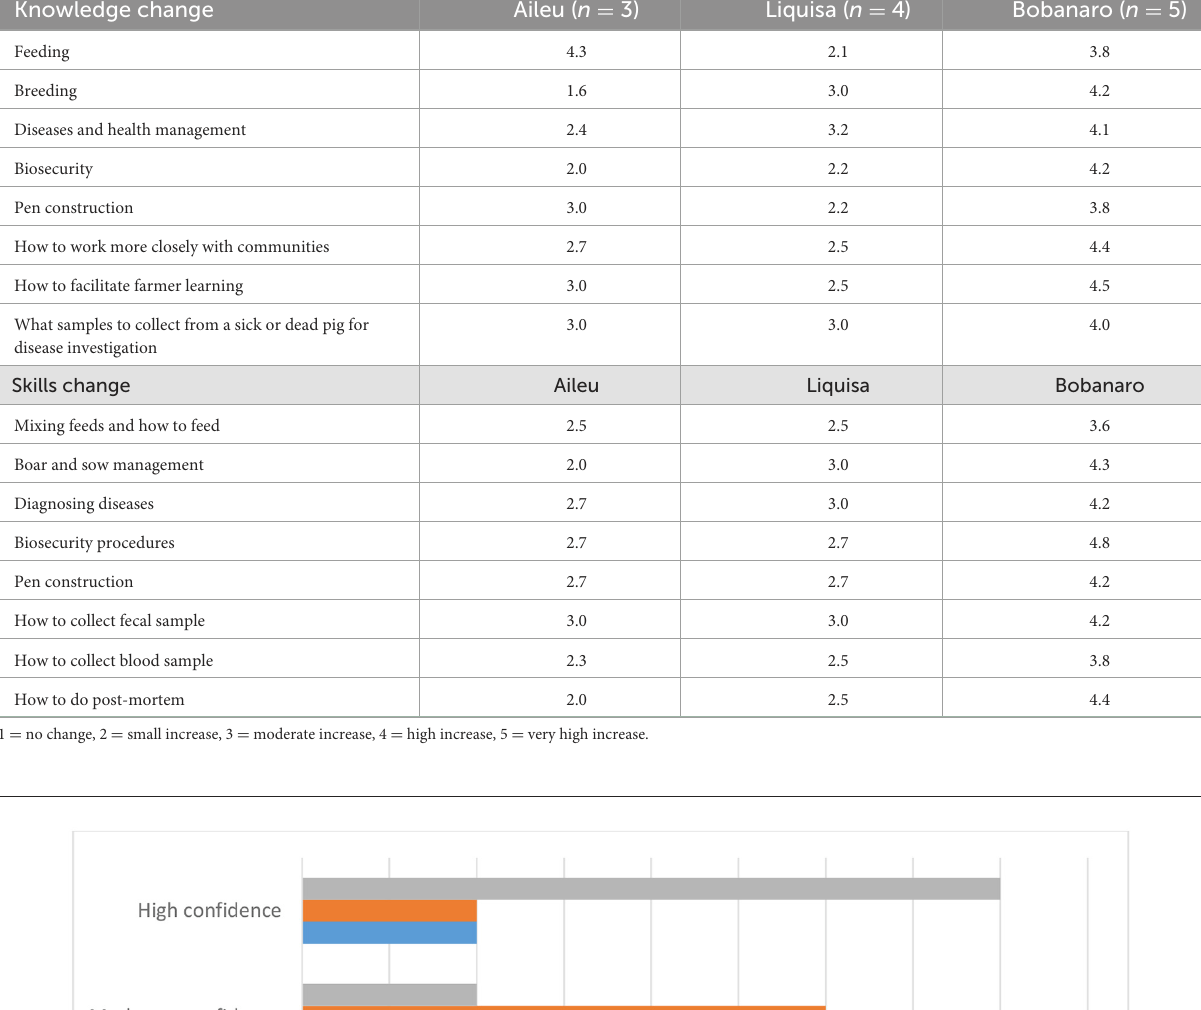
TABLE 9 Self-reported changes in knowledge and skills of technicians ( N = 12) (mean values). Knowledge change